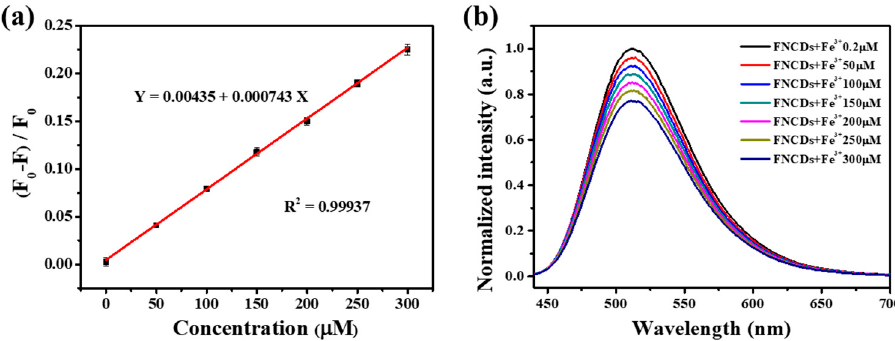
Figure 5. ( a ) Linear fitting of the relative fluorescence vs. concentration plot and ( b ) emission spectra